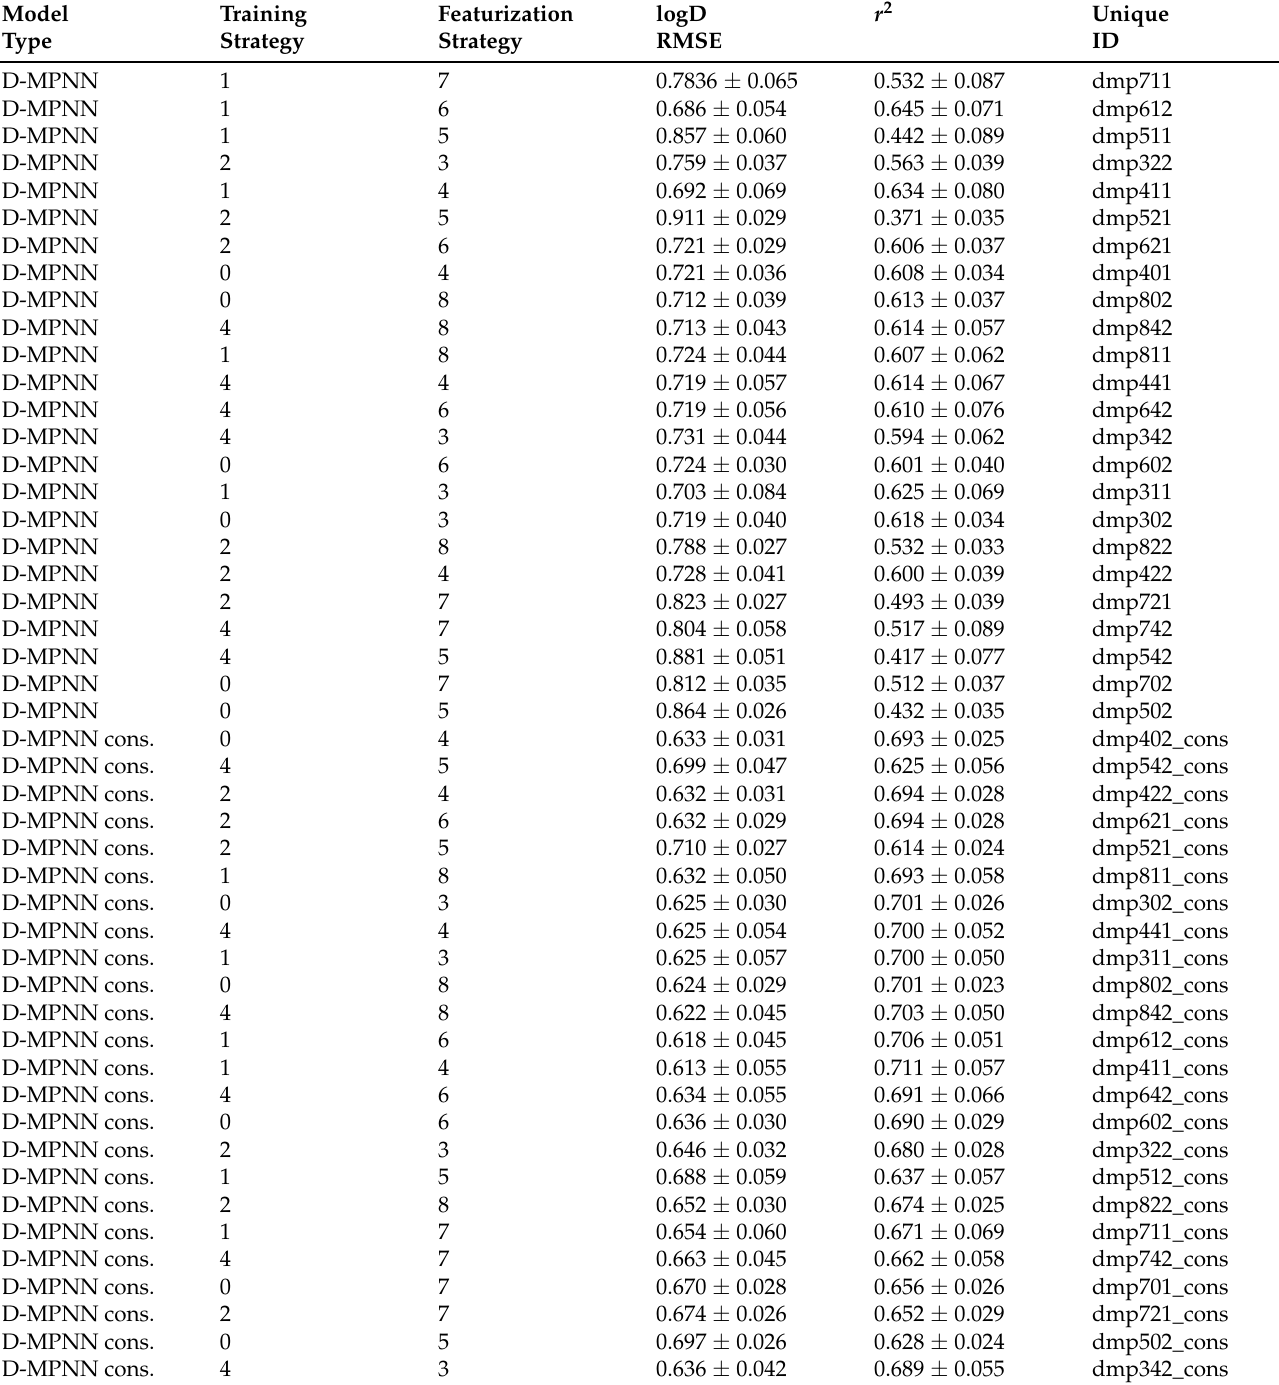
Table A9. Shows the logD RMSE and r 2 results for the D-MPNN model type used during this survey. The last column consists of the unique identifier. Training strategy 0 represents a training strategy combining logD, logS, and logP, 1 represents a strategy combining logD and logP, 2 stands for a combination of logD and logS, 3 represents a strategy using logS and logP, 4 represents a strategy using logD, 5 represents a strategy using logS, and 6 represents a strategy using